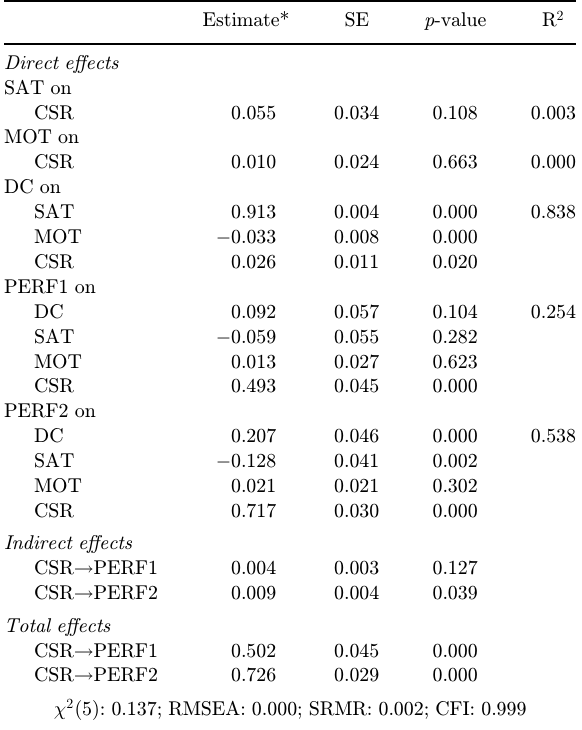
Table 1. Results of the structural equations